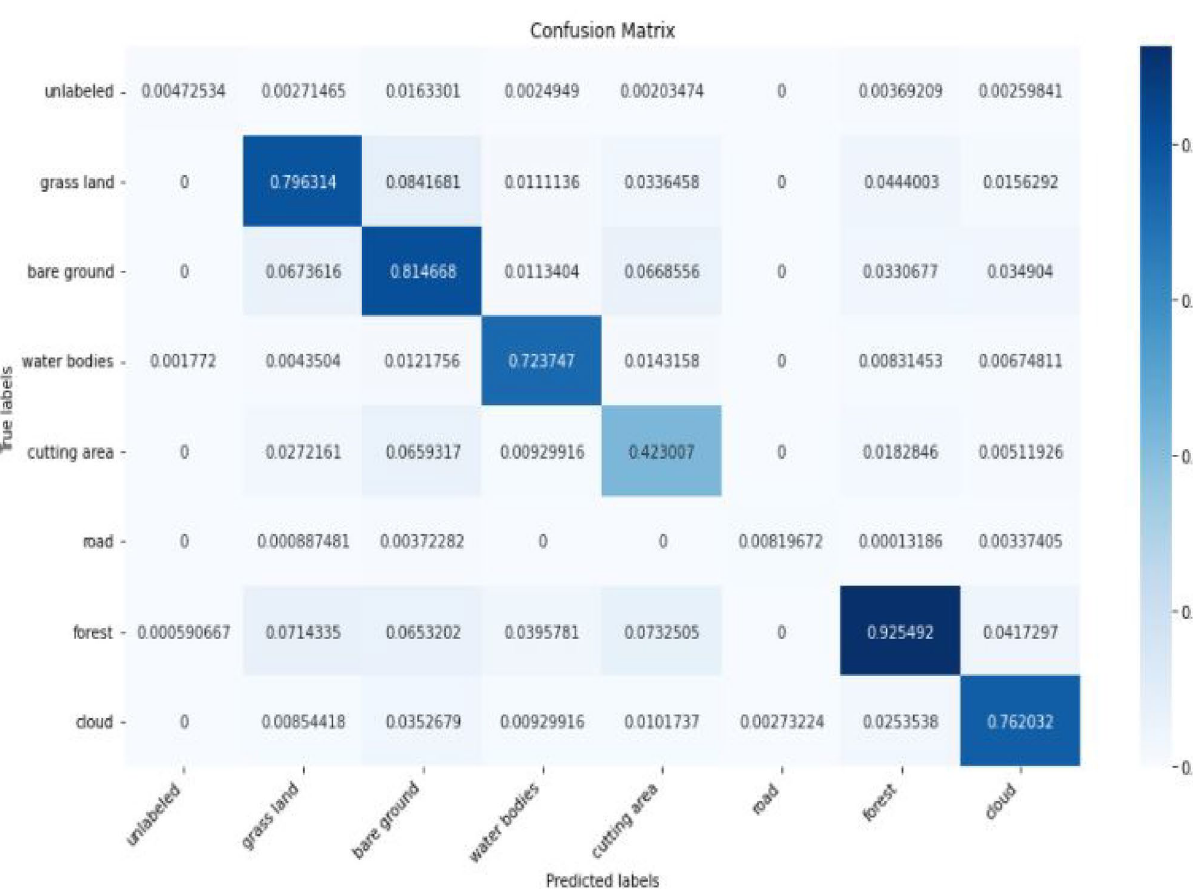
Bold values indicate best score